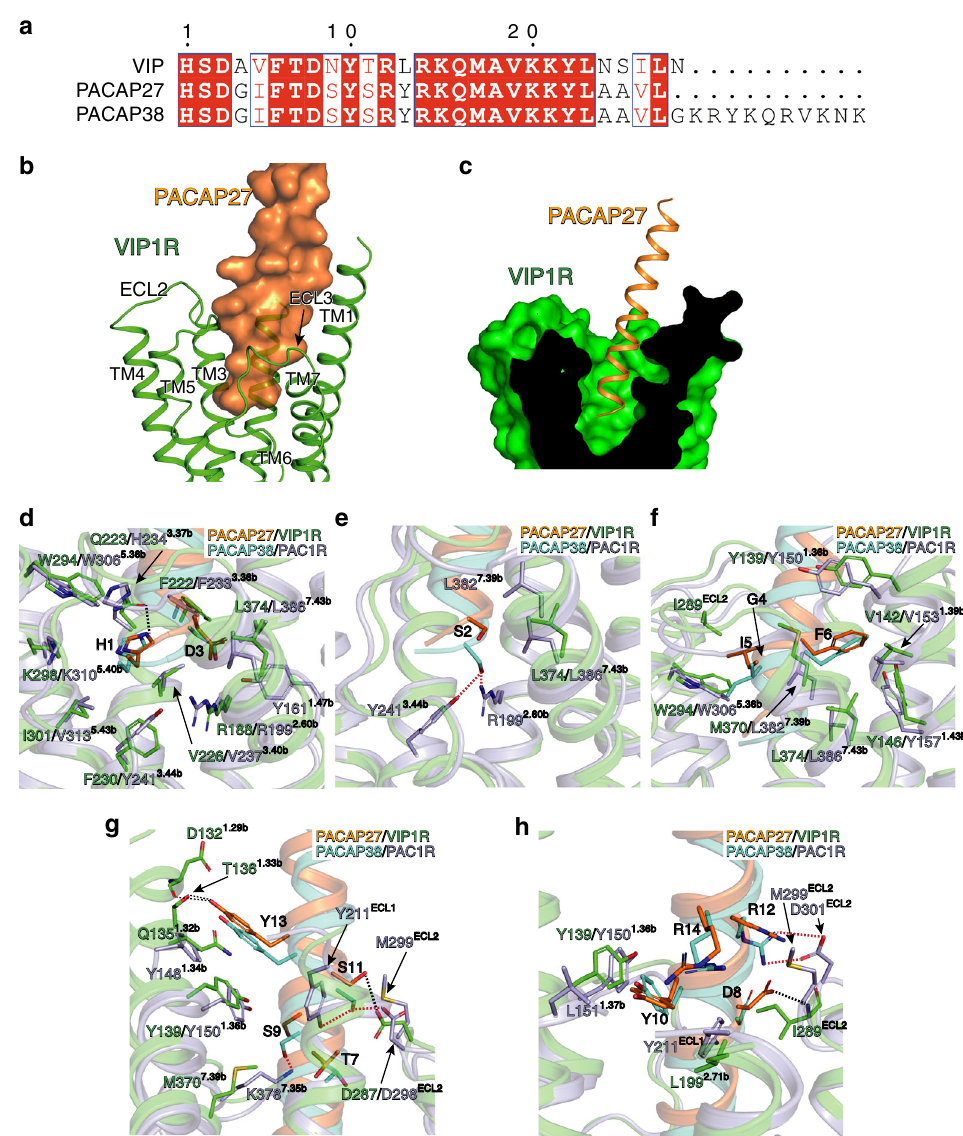
Fig. 3 Comparison of the binding mode of PACAPs to VIP1R and PAC1R. a Sequence alignment of the VIP1R peptide ligands VIP, PACAP27, and PACAP38. b The binding mode of PACAP27 to VIP1R, showing that PACAP27 adopts α -helical conformation and interacts with all TM helices of VIP1R except TM4. c The cross-section view of the PACAP27 binding pocket in the TM bundle of VIP1R. Structural comparisons of PACAP binding pockets in VIP1R and PAC1R. Residues interact with peptide amino acids H1 and D3 ( d ), S2 ( e ), G4, I5, and F6 ( f ), as well as amino acids from T7 to R14 ( g , h ) are shown as sticks. The hydrogen bonds between PACAP27 and residues of VIP1R are marked as black dotted lines, and the hydrogen bonds between PACAP38 and residues of VIP1R are shown as red dotted lines. PACAP27 is colored in orange, and VIP1R in green. PACAP38 is shown in cyan, and PAC1R (PDB code: 6P9Y) in light